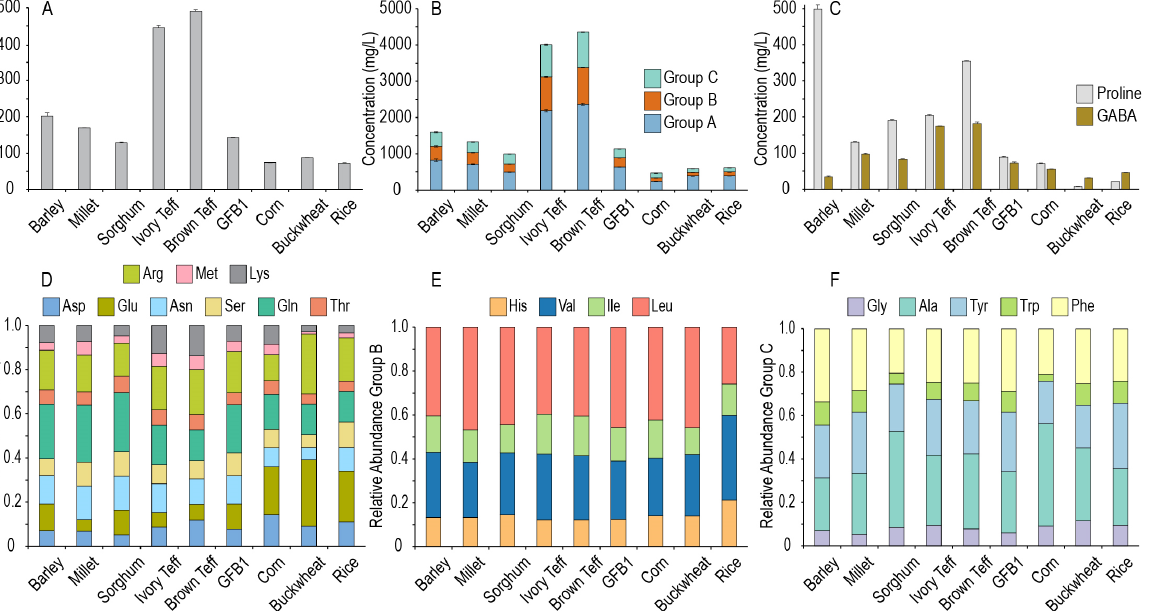
supplementary data). Using the typical goal of producing a wort with 150–200 mg/L FAN,